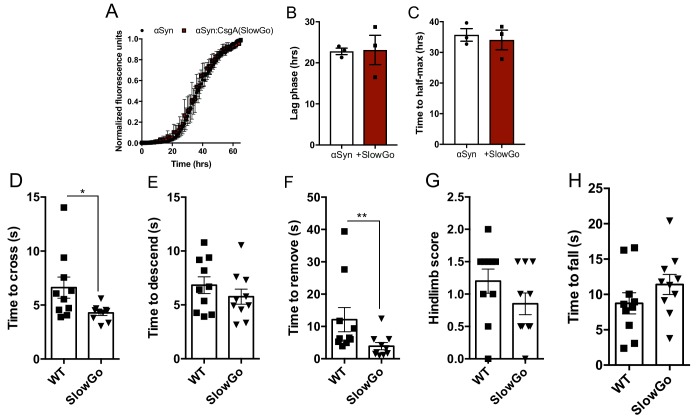
CsgA seeds αSyn aggregation in vitro and in vivo through native amyloidogenic properties.(A) Amyloid aggregation as measured by Thioflavin T fluorescence with αSyn alone or in the presence of non-amyloidogenic CsgA monomers (SlowGo, 25:1 molar ratio, red). Time to reach (B) exponential fibrilization/lag phase and (C) half-maximum from reactions in (A). (D–H) Germ-free Thy1-αSyn mice (ASO) were mono-colonized with E. coli producing either wild-type CsgA (WT) or SlowGo (SlowGo), and motor function assessed at 12-13 weeks of age in (D) beam traversal, (E) pole descent, (F) adhesive removal, (G) hindlimb reflexes, and (H) wirehang. Points represent individuals, bars represent the mean and standard error, n = 10–11 (D–H). Data in (D–H) analyzed by two-tailed Mann-Whitney test. *p≤0.05; **p≤0.01.Figure 3—figure supplement 2—source data 1.Source data and statistical analysis.